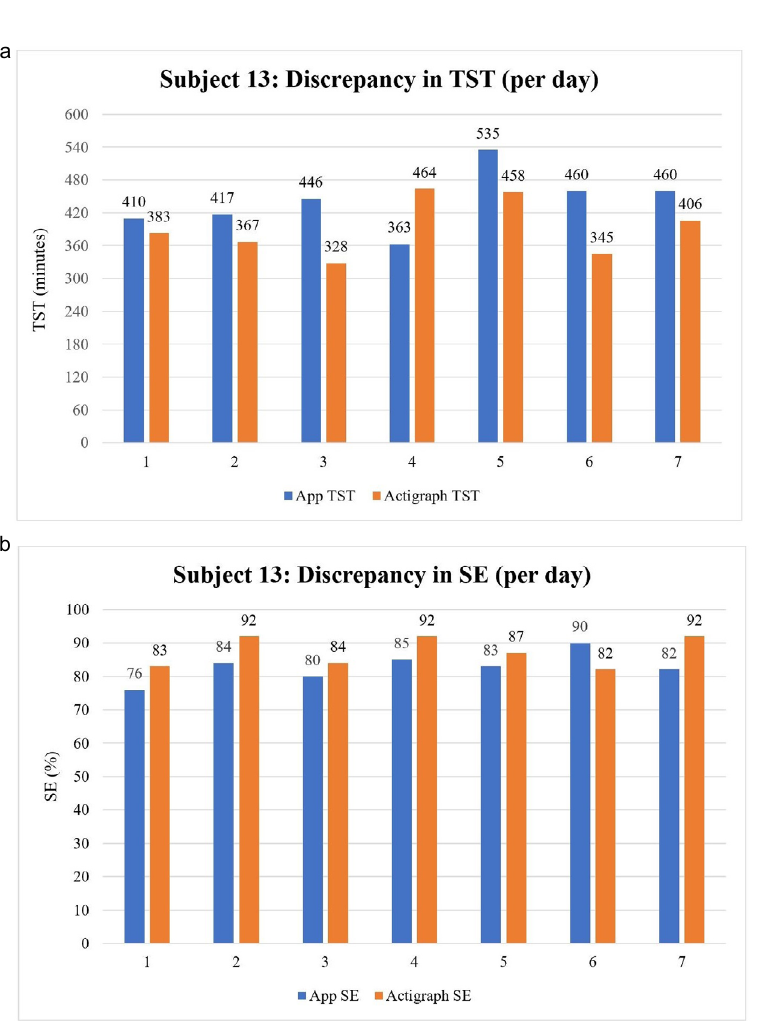
Figure 3. Subject 13: Sleep daily discrepancy calculations between App and actigraph in one representative participant. (a) Discrepancy in TST (per day) Graph depicting daily discrepancy in TST calculations; (b) discrepancy in SE (per day) Graph depicting daily discrepancy in sleep efficiency calculations